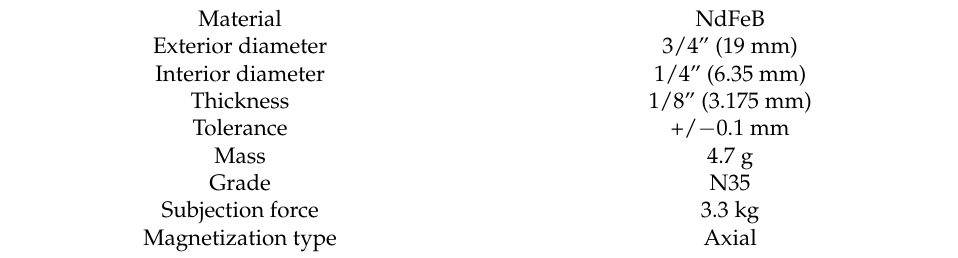
Table 2. Properties of the N45 magnet used for the magnetic spring system [23].